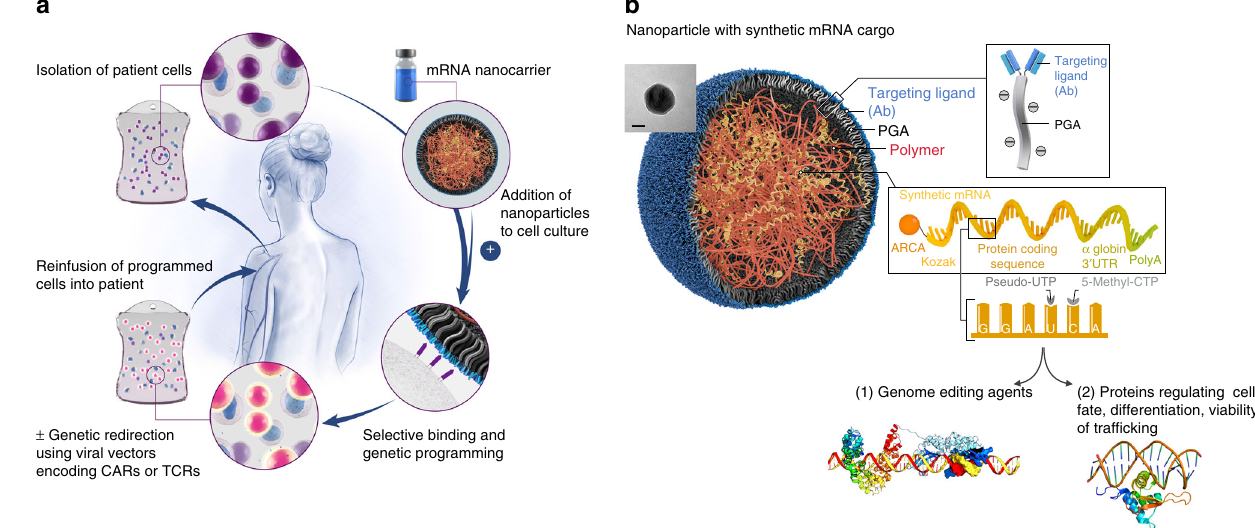
Fig. 1 Creating mRNA nanoparticles to program therapeutic T-cells. a Schematic explaining how cultured T-cells can be programmed to express therapeutically relevant transgenes carried by polymeric nanoparticles (NPs). These particles are coated with ligands that target them to speci fi c cell types, enabling them to introduce their mRNA cargoes and cause the targeted cells to express selected proteins (like transcription factors or genome-editing agents). b Design of targeted mRNA-carrying NPs. The inset shows a transmission electron micrograph of a representative NP; scale bar , 50 nm. Also depicted is the synthetic mRNA encapsulated in the NP, which is engineered to encode therapeutically relevant